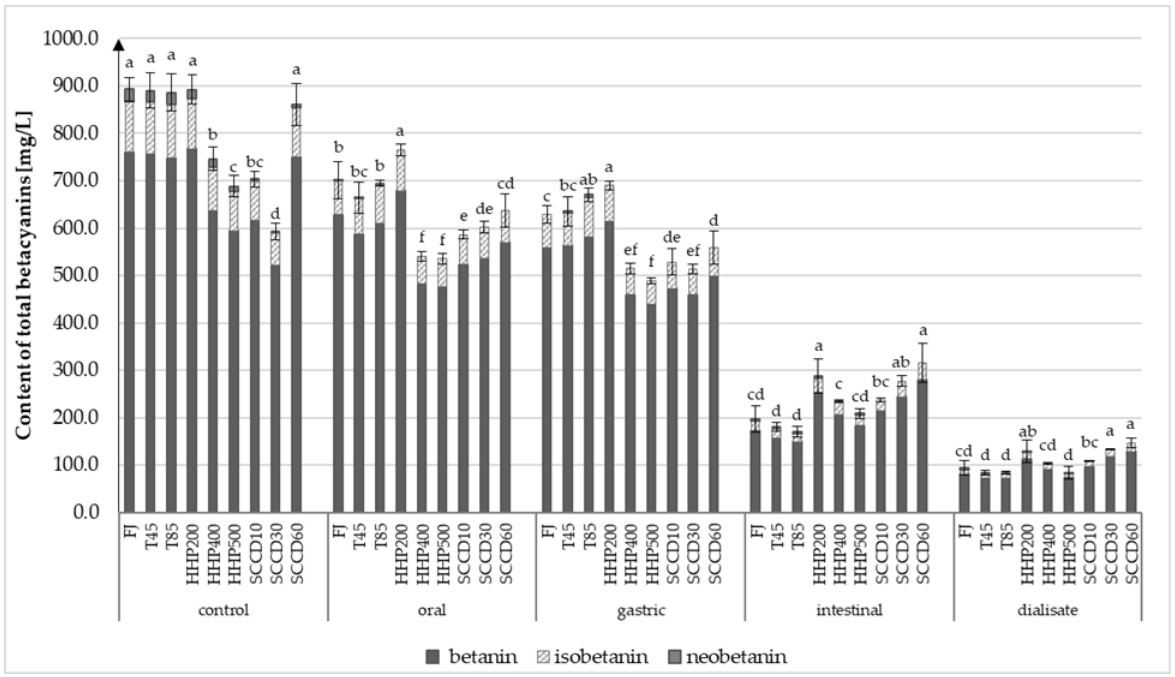
Figure 1. Content of total betacyanins (betanin, isobetanin, and neobetanin) in beetroot juice after different processing on every stage of simulated gastro-intestinal digestion. FJ — untreated juice; T45 — thermal treatment of sample at 45 °C; T85 — pasteurized sample at 85 °C; HHP200 — sample subjected to HHP at 200 MPa; HHP400 — sample subjected to HHP at 400 MPa; HHP500 — sample subjected to HHP at 500 MPa; SCCD10 — sample treated by SCCD at 10 MPa; SCCD30 — sample treated by SCCD at 30 MPa; SCCD60 — sample treated SCCD at 60 MPa. (Different letters over the bars indicate significant differences between total betacyanins content at each step of simulated digestion ( p ≤ 0.05).